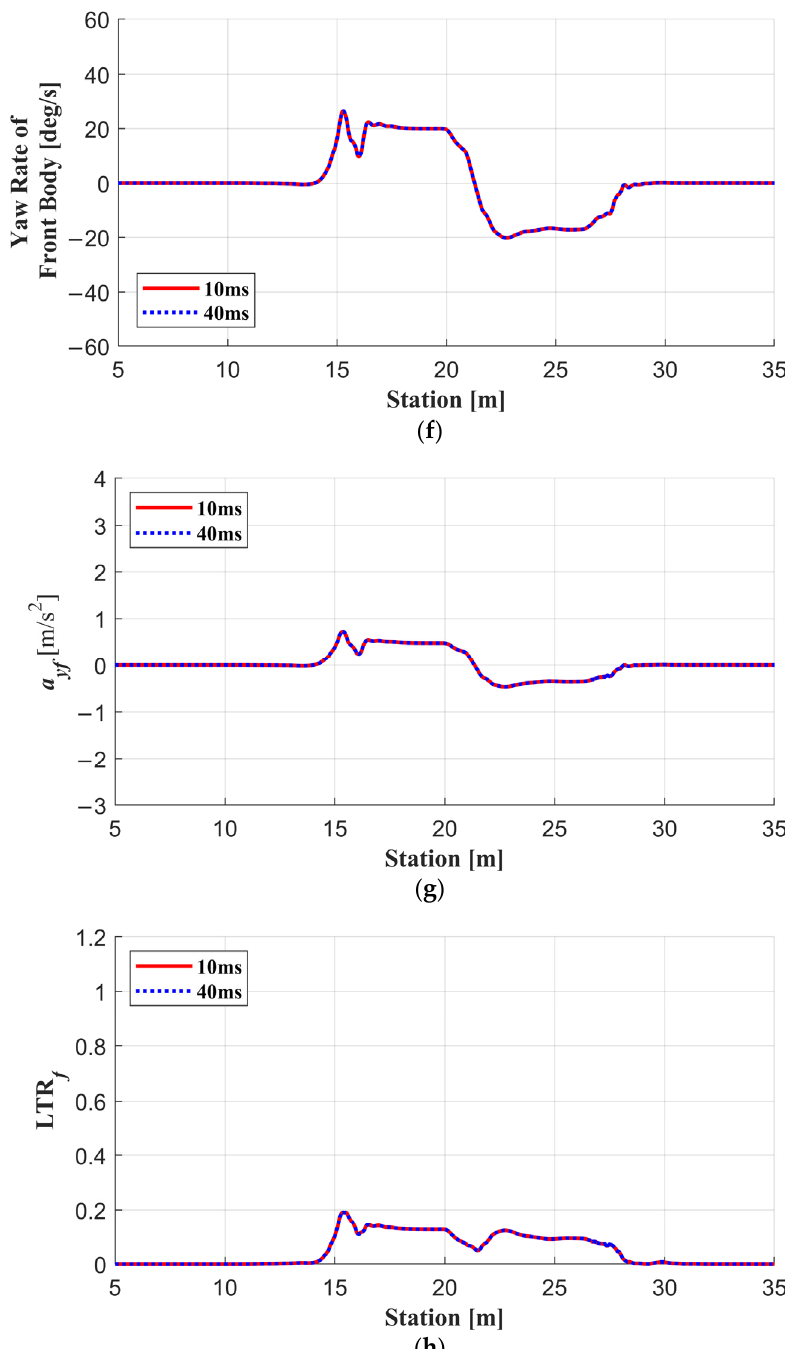
Figure 8. Simulation results of each algorithm: ( a ) driving trajectory, ( b ) lateral error, ( c ) heading angle error, ( d ) articulation Ile, ( e ) speed of the front body, ( f ) yaw rate of the front body, ( g ) lateral acceleration of the front body, and ( h ) LTR of the front body.